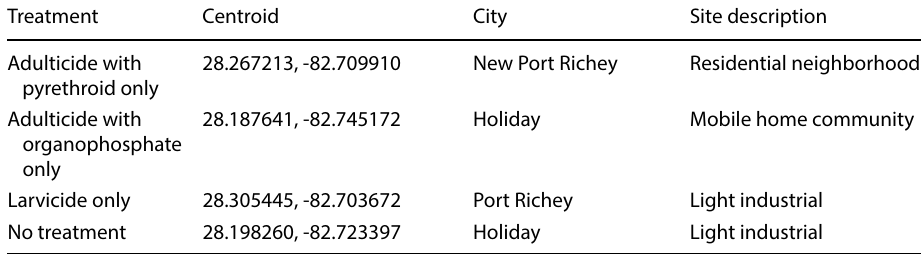
Table 1 The central point, city, and site description of each treatment area in Pasco County, Florida